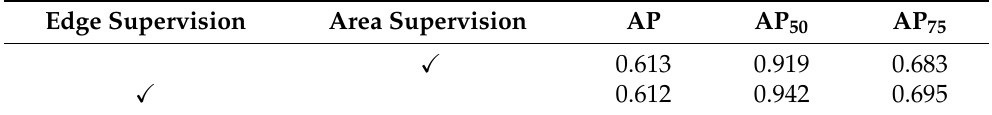
Table 5. A comparison of the effect of adding edge supervision module and region supervision module on the results on UCAS-AOD dataset. (AP is the average of 10 values of AP taken between IoU = 50 and IoU = 95. AP 50 is the AP value obtained in the IoU = 50, and AP 75 is the AP value obtained at IoU =